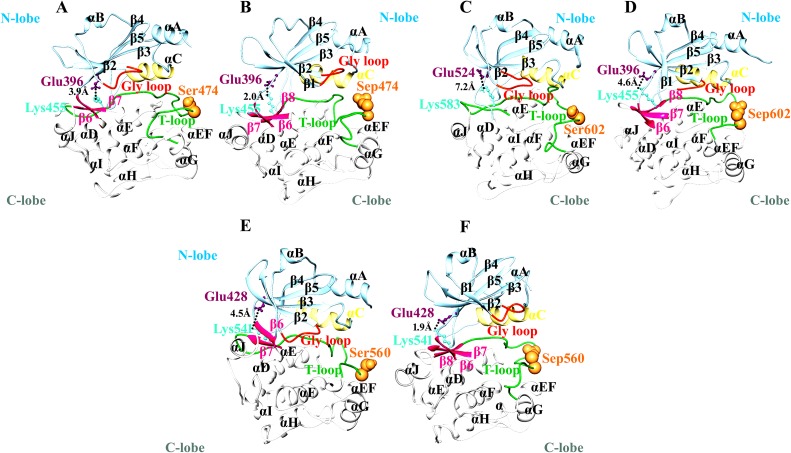
Comparative ribbon analysis of group-II PAKs on the basis of MD simulation analysis.Ribbon representation of (A and B) PAK4 and PAK4Sep474, (C and D) PAK5 and PAK5Sep602 and (E and F) PAK6 and PAK6Sep560 structures. Color codes are given in the Fig 3 legend.